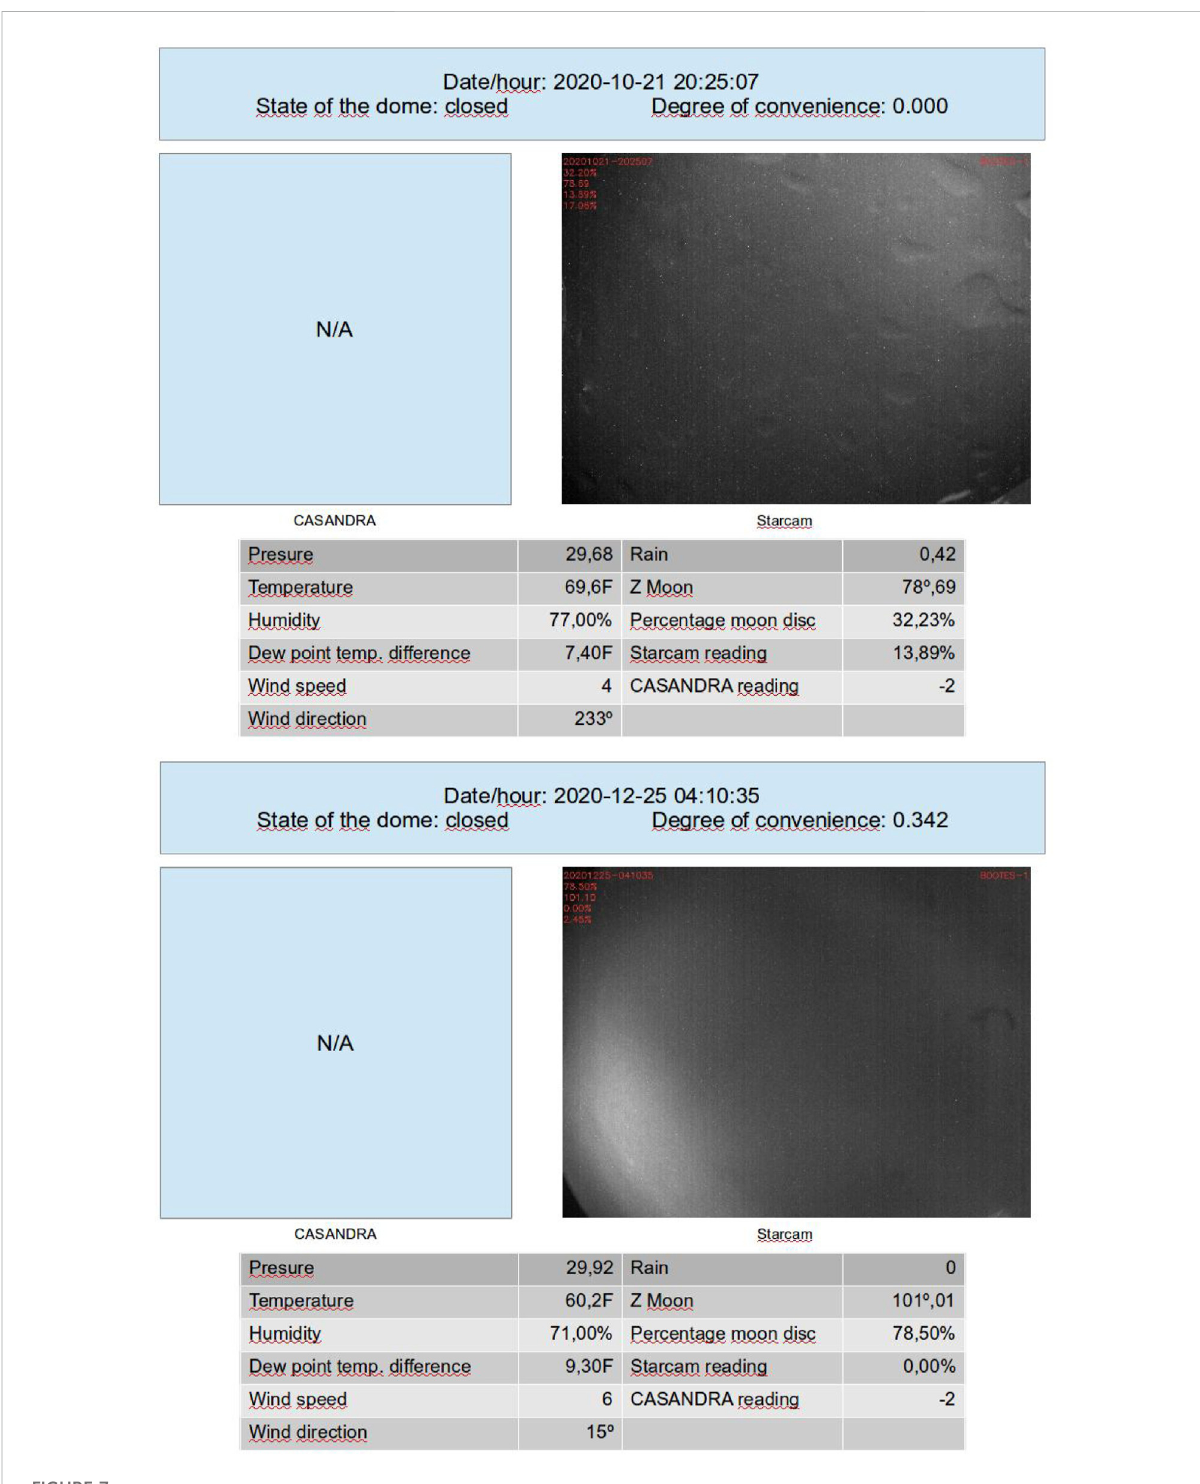
FIGURE 7 Degree of suitability indicates close dome, and the dome was